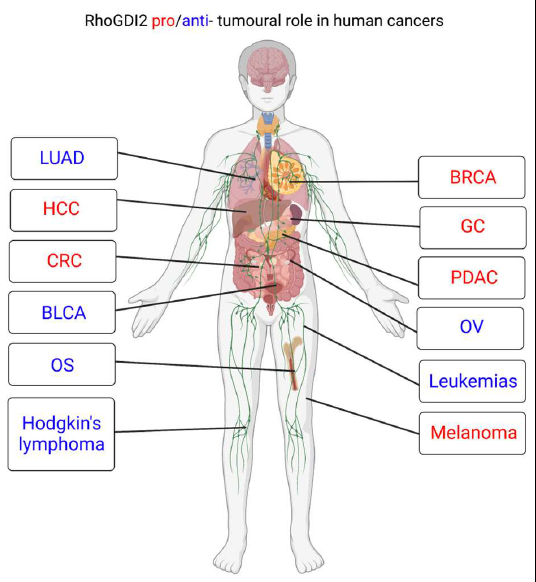
Figure 4. RhoGDI2 in cancer. Based on in vitro experiments and on correlation studies using human tumour samples, RhoGDI2 has been described as possessing either pro- or anti-tumour functions, depending on cancer types. It plays a tumour promoting role in hepatocellular carcinoma (HCC), colorectal carcinoma (CRC), breast cancer (BRCA), gastric cancer (GC), pancreatic ductal adenocarcinoma (PDAC) and skin cutaneous melanoma (SKCM). It plays a tumour suppressive role in lung adenocarcinoma (LUAD), bladder cancer (BLCA), osteosarcoma (OS), Hodgkin’s lymphoma, ovarian (OV) cancer and in multiple leukemias. Created with Biorender.com (accessed on 28 January